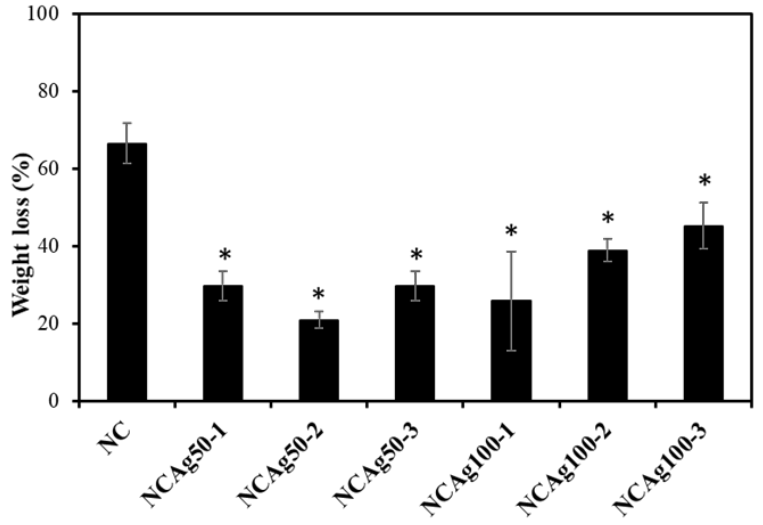
Figure 8. Biodegradation in soil of NC, NCAg50, and NCAg100 films after 2 weeks. The symbol * indicates a significant difference ( p < 0.05, n = 3) vs. NR films.